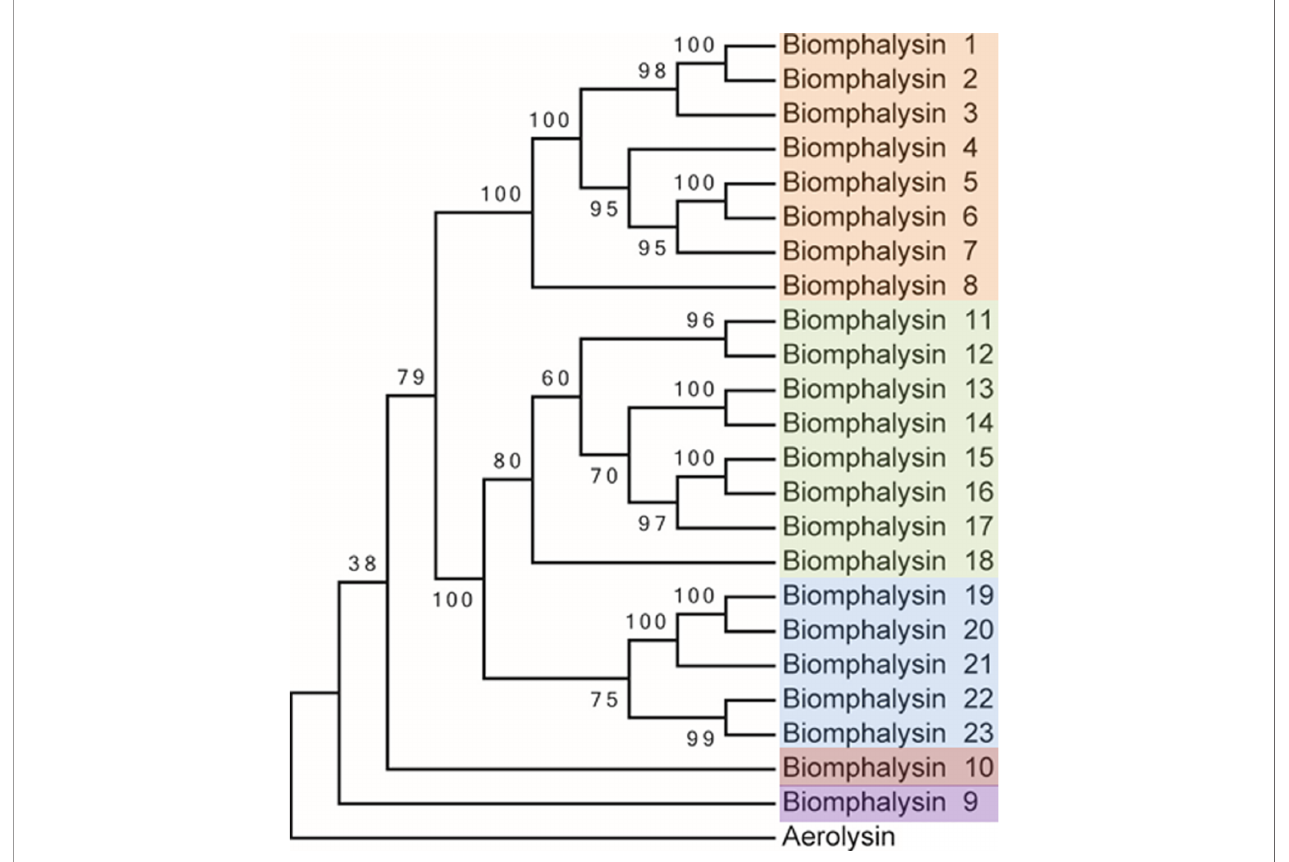
FIGURE 1 | Phylogenetic analysis of the protein sequences from the 23 biomphalysins from Biomphalaria glabrata . The three clusters identi fi ed in this analysis are highlighted in orange, green and blue for the clusters I, II and III that contain biomphalysins 1 to 8, 11 to 18 and 19 to 23, respectively. Biomphalysin 9 in purple and 10 in red do not group within biomphalysin clusters. The aerolysin sequence from Aeromonas hydrophila (GenBank P09167) was used as an outgroup. aLRT was carried out on the tree inferred from the Maximum Likelihood method. Ratio test values multiplied by 100 are shown at each branch of the trees. The accession number of each gene and protein used is listed in Table S1